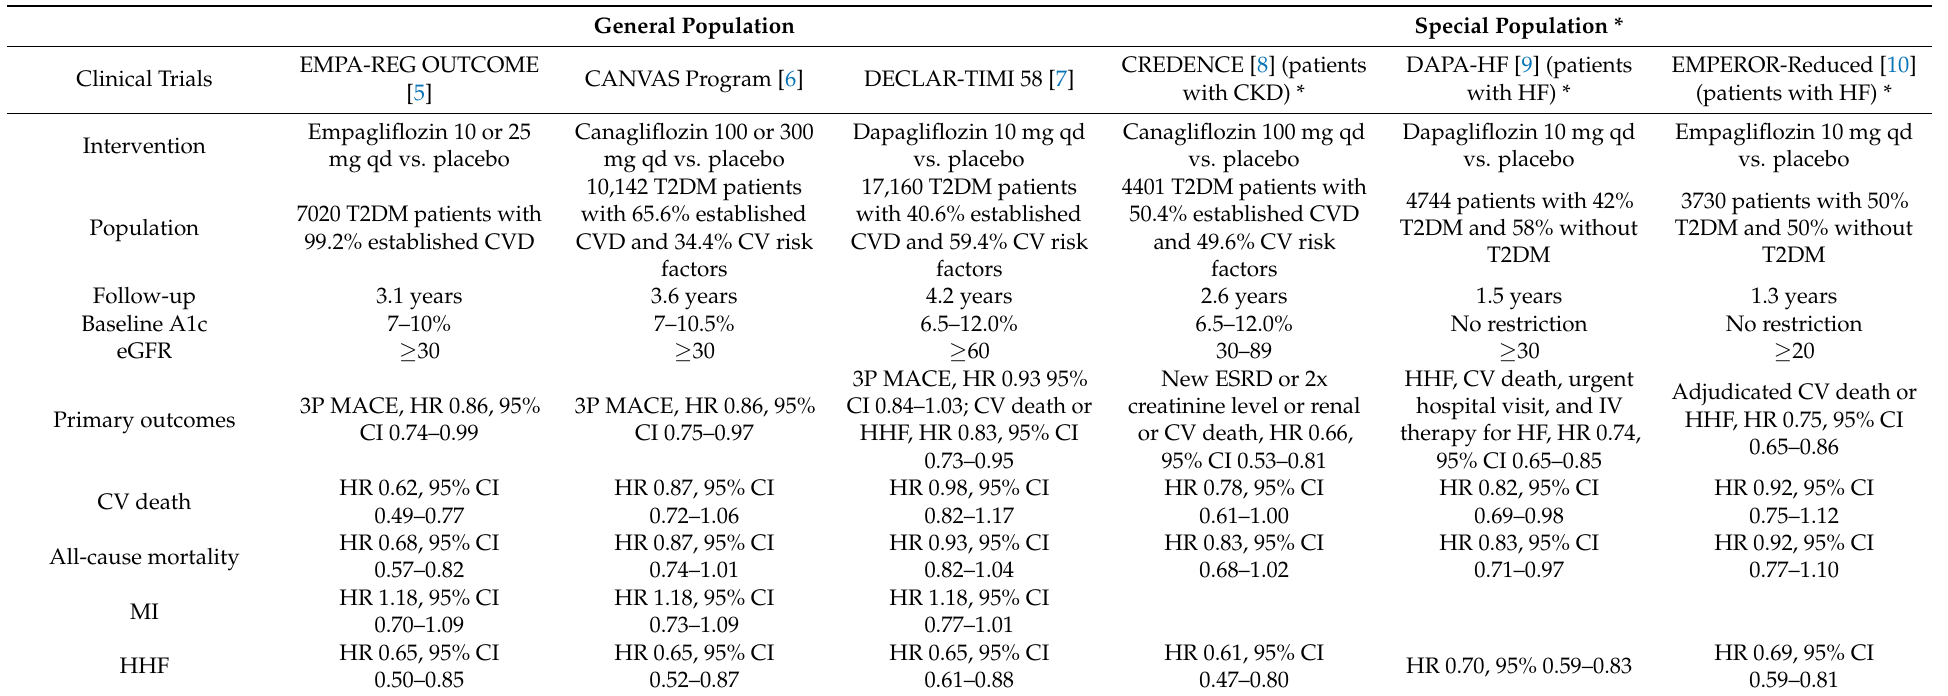
Table 1. Clinical Trials of SLGT2